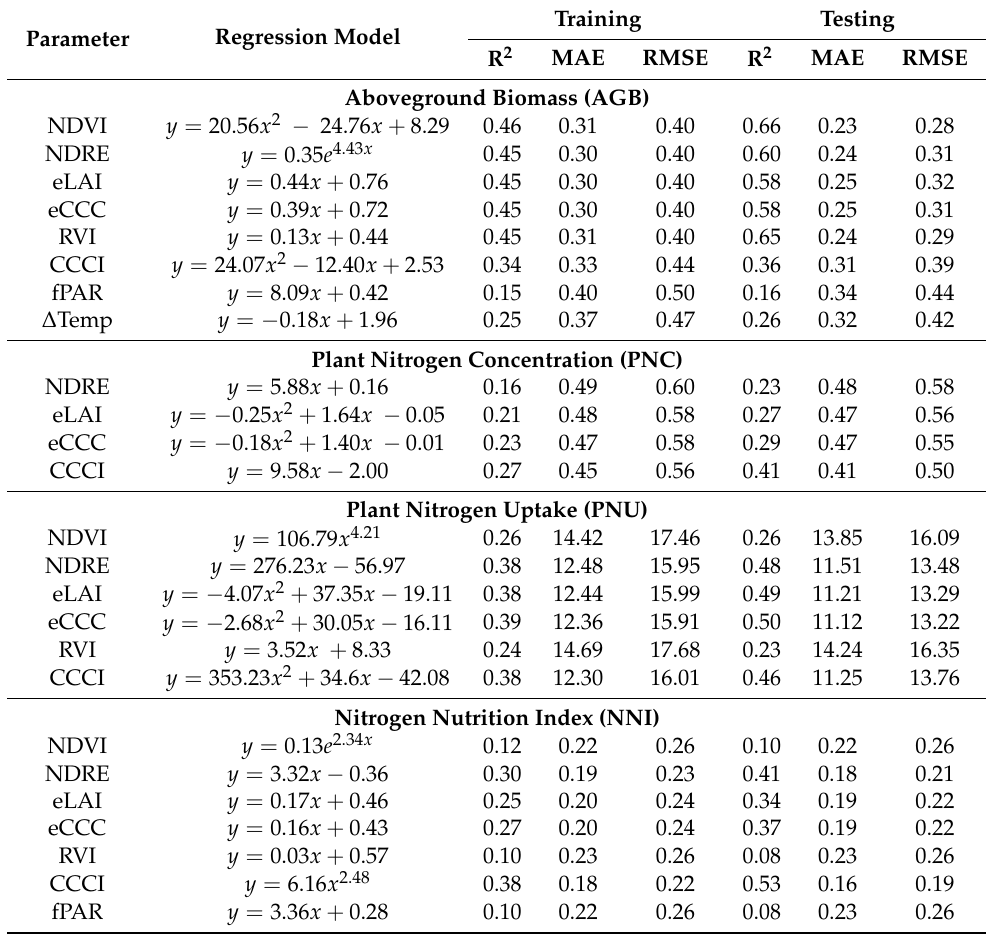
Table 3. The performance of simple regression (SR) models using Crop Circle Phenom sensor parame- ters for predicting corn N status indicators across years and treatments. NDVI: normalized difference vegetation index; NDRE: normalized difference red edge; eCCC: estimated canopy chlorophyll content; eLAI: estimated leaf area index; RVI: ratio vegetation index; CCCI: canopy chlorophyll content index; fPAR: fractional photosynthetically active radiation; MAE: mean absolute error;